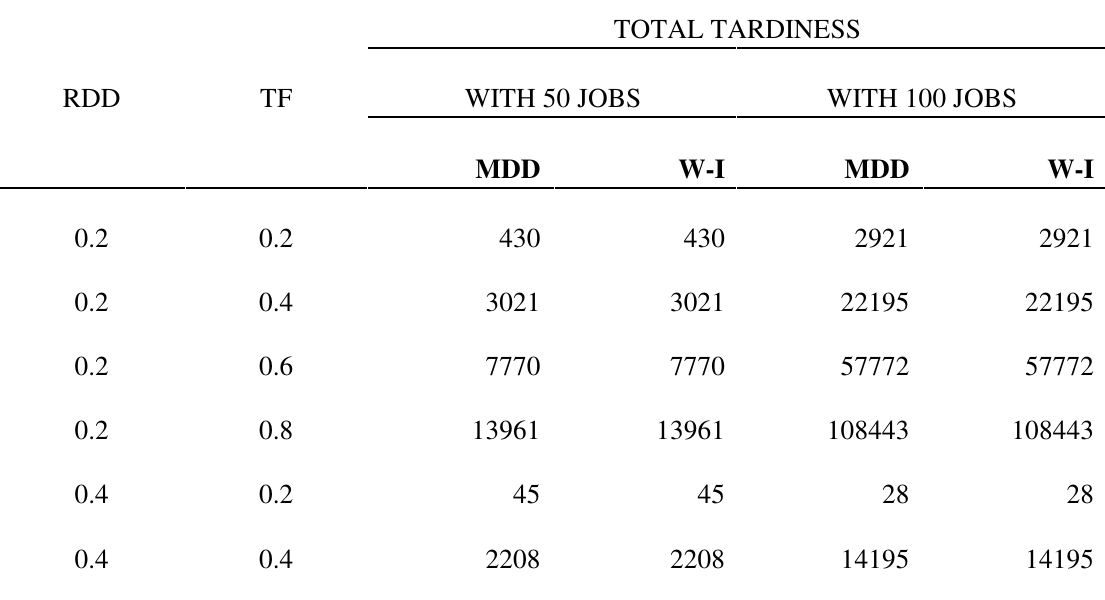
Tardiness values obtained for MDD and W-I heuristics for problems with 50 and 100 jobs. TOTAL